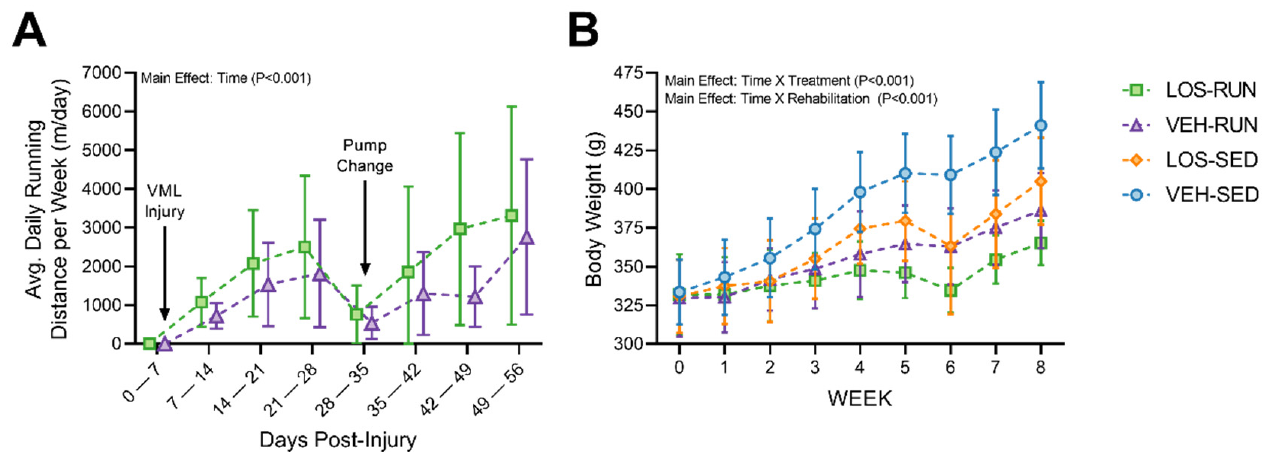
Figure 2. Running wheel and body weight evaluation over the 56 DPI time course of the study. ( A ) Daily running distances for each animal were averaged per week for LOS-RUN and VEH-RUN experimental groups. A gradual increase in daily running was observed; with the exception of the week injury was induced and osmotic pumps were explanted. Data are presented as mean ± SD; n = 7 rats per group. Differences were considered significant when p < 0.05 by fitting a Mixed-Effects model and the Holm-Sidak post hoc method. ( B ) Body weights were measured each week for all animals in the sedentary and running experimental groups. Animals gained weight throughout the duration of the study, as expected, with the running rehabilitation groups having the least increase. Data are presented as mean ± SD; n = 7–8 rats per group. Differences were considered significant when p < 0.05 by a three-way ANOVA followed by the Holm–Sidak post hoc test.